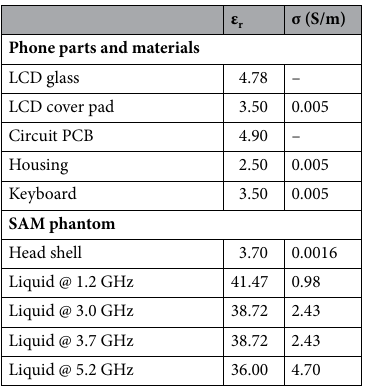
Table 2. Dielectric properties of the phone material and SAM